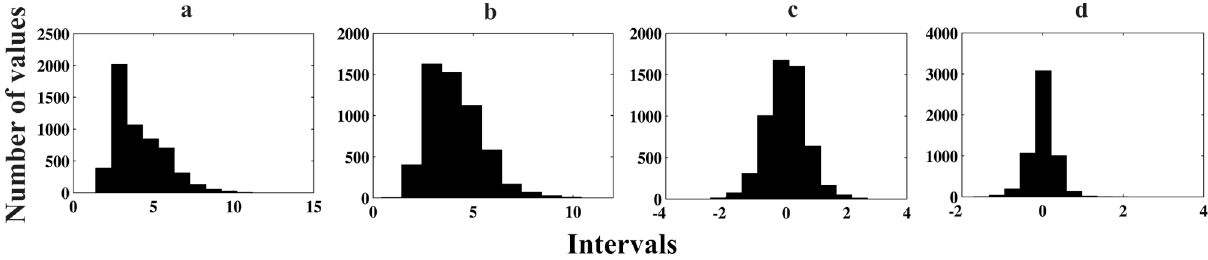
Figure 2. Distribution estimates using histograms: (a) histogram of the original time series foF2; (b,c,d) histograms of the components f 01 ( t ), g 3 ( t ), g 2 ( t 0 0